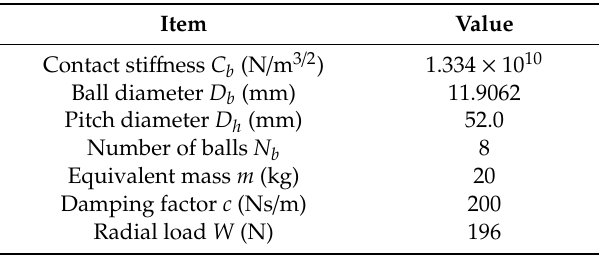
Table 1. Specifications of JIS6306 ball bearing